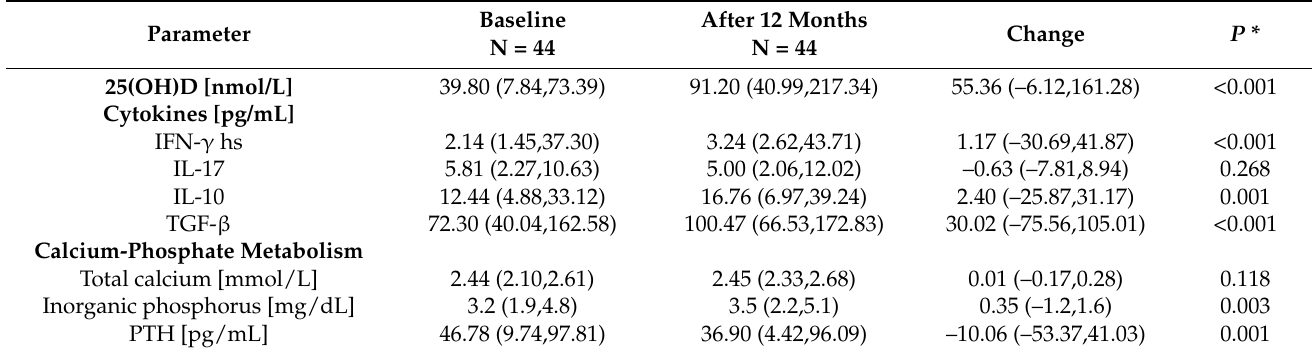
Table 4. Median values of serum levels of 25(OH)D, cytokines and calcium-phosphate metabolism parameters at baseline and after 12 months of Vitamin D